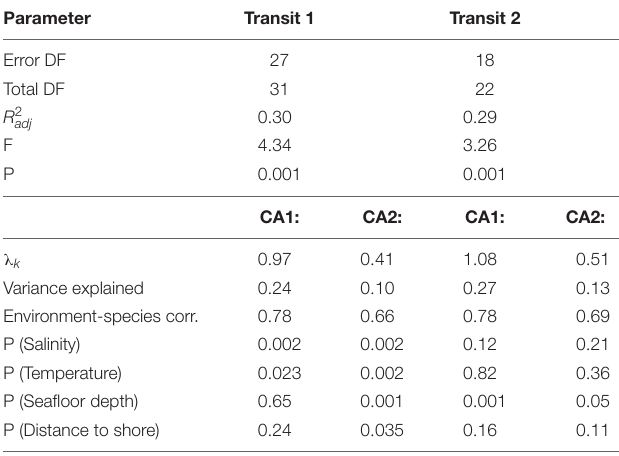
TABLE 2 | Ordination results from the first two canonical axes (CA1 and CA2) for redundancy analyses (RDA) on two descriptive metrics of shallow and deep SLs: average S v strength (dB re 1 m − 1 ), scattering layer thickness (m); and on for four glider-derived environmental variables: salinity (g kg − 1 ) and temperature ( ◦ C) from the 90 to 100 m depth range, seafloor depth (m), and distance to shore